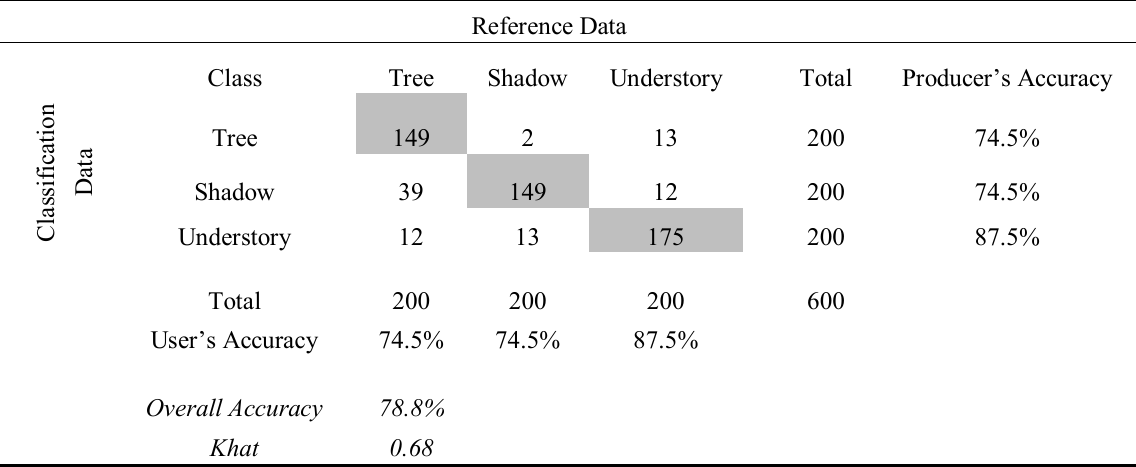
Table 5. Classification accuracies summarized in a confusion matrix for each hierarchical level. Level I: Validation of Objects (Shadow, Crown and